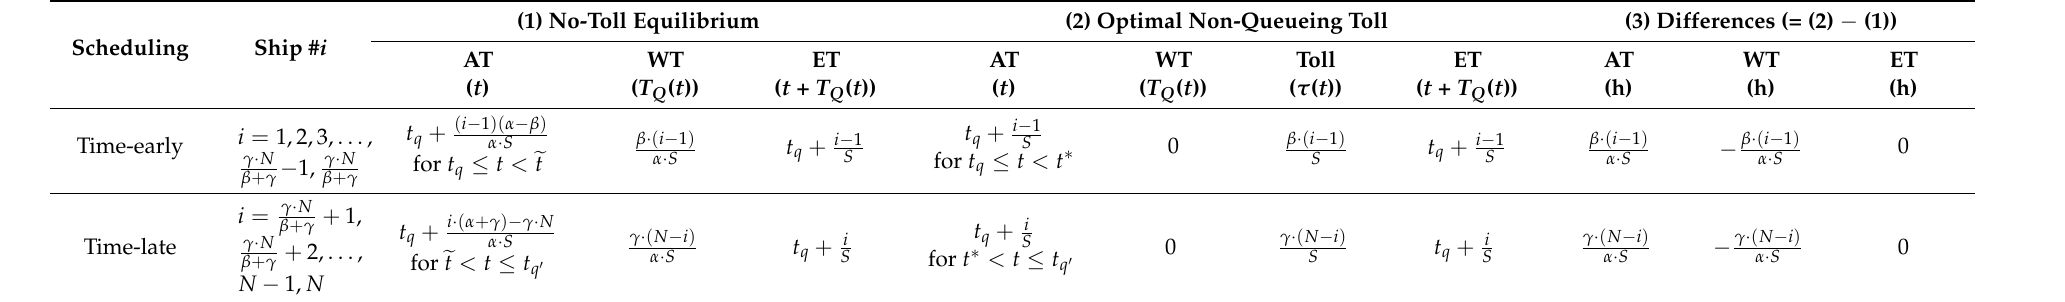
Table 6. Successive results for ship # i ( i = 1,2,3, . . . , N ) from the no-toll to the tolled